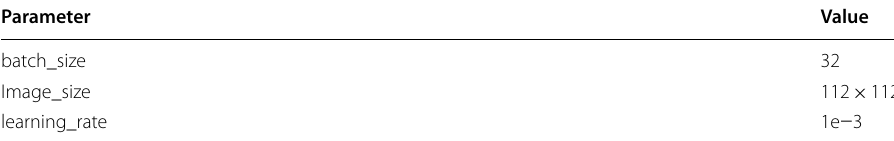
Table 1 Training parameters